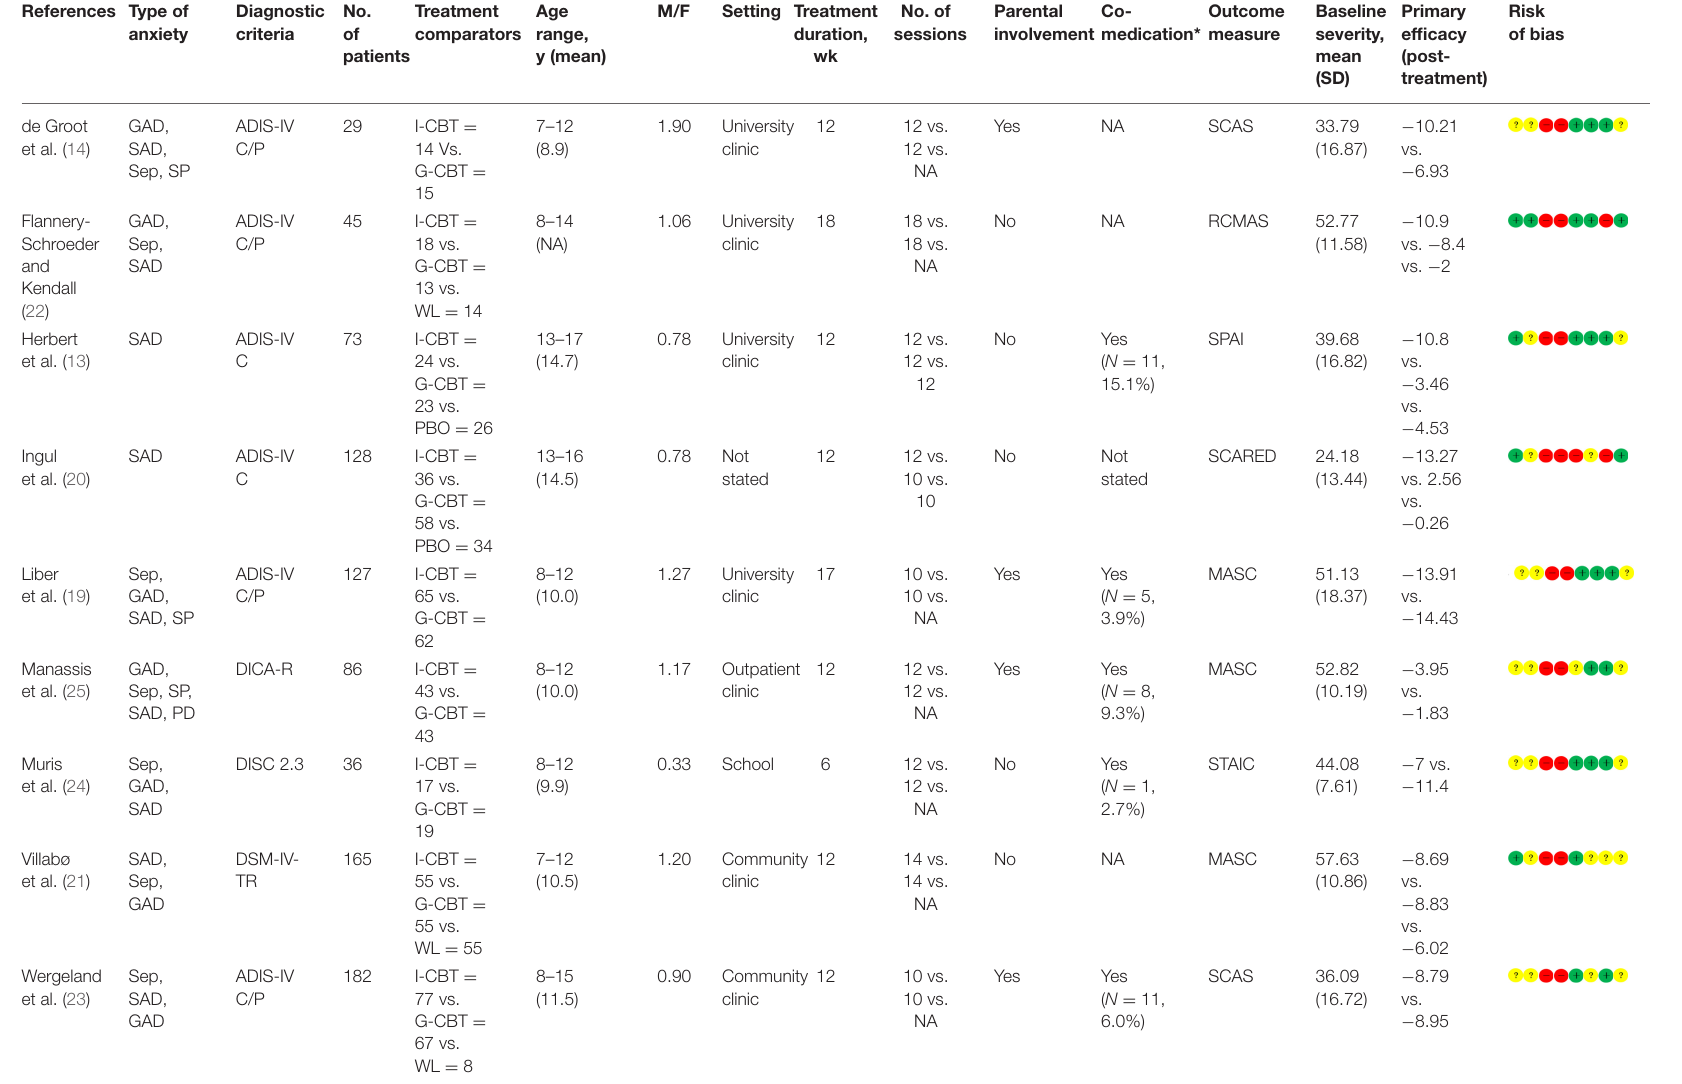
GAD, generalized anxiety disorder; SAD, social anxiety disorder/social phobia; Sep, separation anxiety disorder; SP, specific/simple phobia; PD, panic disorder; ADIS, Anxiety Disorders Interview Schedule for DSM-4; DISC, Diagnostic InterviewScheduleforChildren;DICA,DiagnosticInterviewforChildrenandAdolescents-Revised;DSM,DiagnosticandStatisticalManualofMentalDisorders;M/F,man/female;SCAS,SpenceChildren’sAnxietyScale;RCMAS,Revised Children’s Manifest Anxiety Scale; SPAI, Social Phobia Anxiety Inventory for Children; SCARED, Screen for Child Anxiety Related Emotional Disorders; MASC, Multidimensional Anxiety Scale for Children; STAIC, State–Trait Anxiety Inventory for Children; the risk of bias were as follows: random sequence generation, allocation concealment, blinding of participants and personnel, blinding of outcome assessment, incomplete outcome data, selective reporting, other bias and total risk, I-CBT, individual cognitive behavioral therapy; G-CBT, group cognitive behavioral therapy; WL, waitlist; PBO, psychological placebo. * Co-medication interventions included psychotropic medications, such as methylphenidate and serotonin reuptake inhibitors. − : high risk of bias, + : low risk of bias, ?: unclear risk of